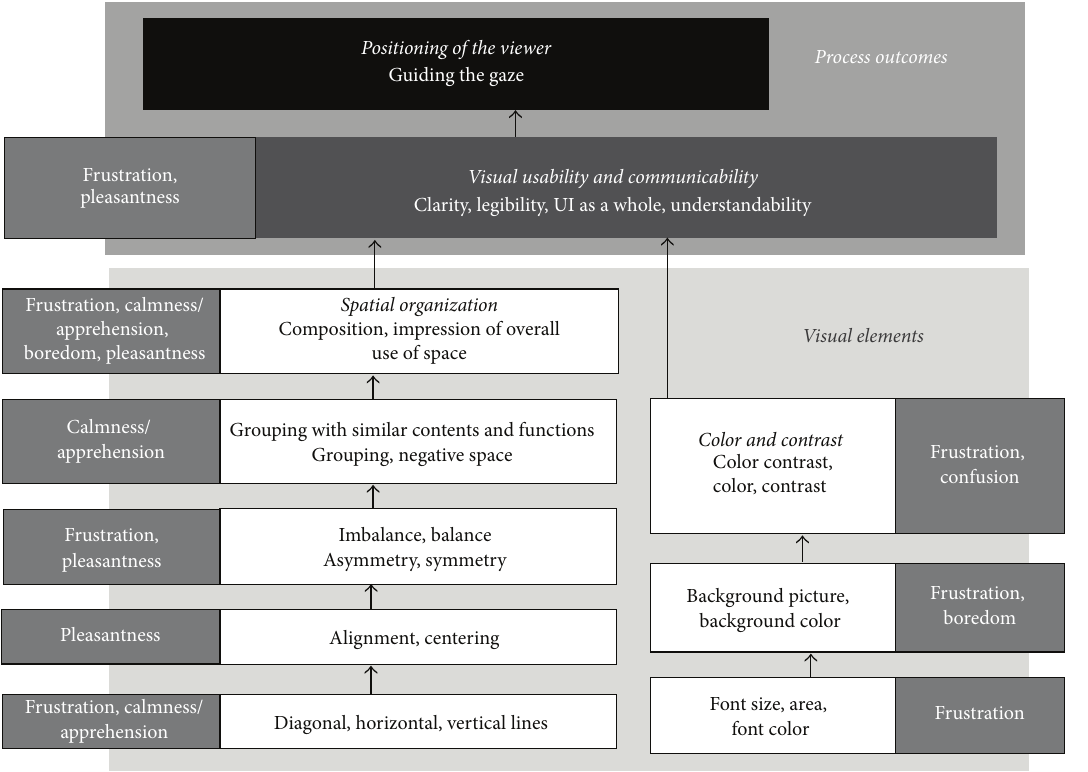
Figure 7: Salient visual elements eliciting